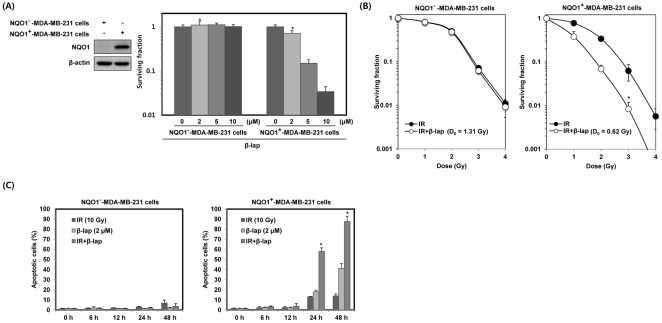
β-lap induces radiosensitization in an NQO1-dependent manner.(A) NQO1− or NQO1+-MDA-MB-231 cells were treated with various concentrations of β-lap. Cells were allowed to grow for 10 to 14 days and were stained with 0.5% crystal violet and scored for colony formation. Results from three independent experiments are expressed as means ± SEM. *Significant difference between NQO1−- and NQO1+-MDA-MB-231 cells after β-lap treatment at p<0.05. (B) Cells were treated with 2 µM β-lap and then exposed to increasing doses of IR 30 min after treatment with β-lap. After 14 days, cells were scored for colony formation. Results from three independent experiments are expressed as means ± SEMs. (C) Cells were treated with IR alone, β-lap alone or the combination of IR and β-lap for the indicated times. The percentage of cells with sub-G1 DNA content was determined by flow cytometry. Results from three independent experiments are expressed as means ± SEMs.